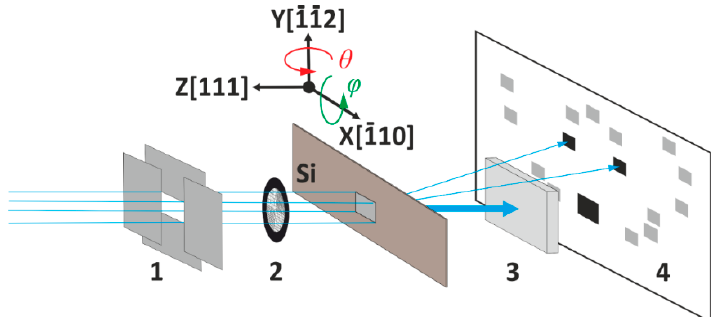
Figure 5. The scheme of the experiment: 1- system of slits; 2- sample in the study (grid); (3-aluminum Figure5. Theschemeoftheexperiment: 1—systemofslits; 2—sampleinthestudy(grid); (3—aluminum filter; 4- charge-coupled device (CCD) camera. filter; 4—charge-coupled device (CCD)